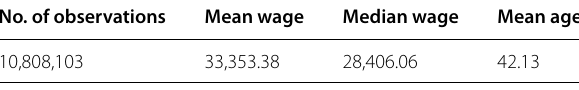
Table 8 Summary statistics SIAB, comparable sample 2